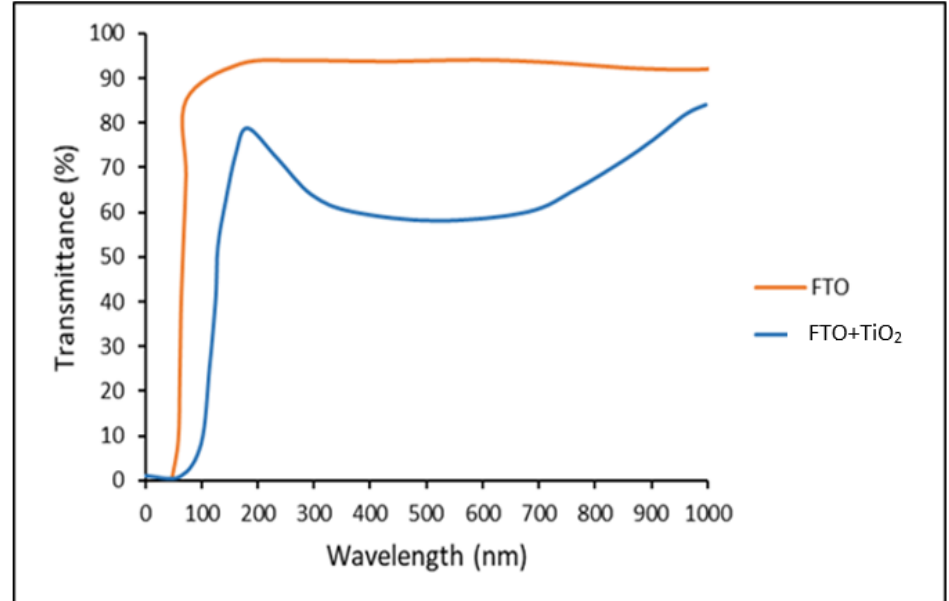
Figure 11. Transmitter spectra of FTO and TiO 2 films cast on FTO.